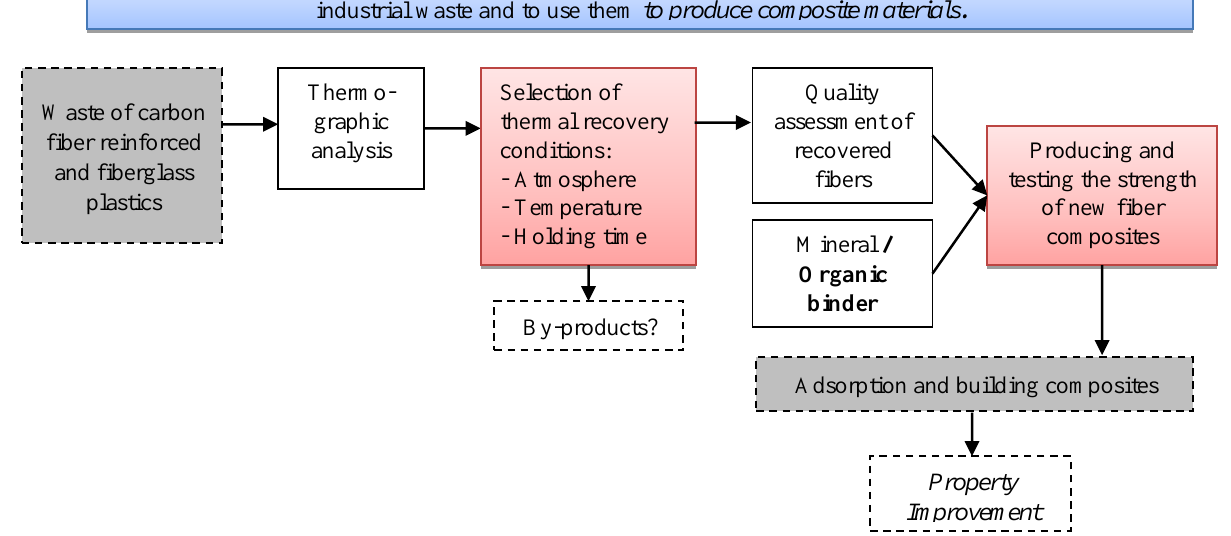
Figure 2. Flowchart to explain the study